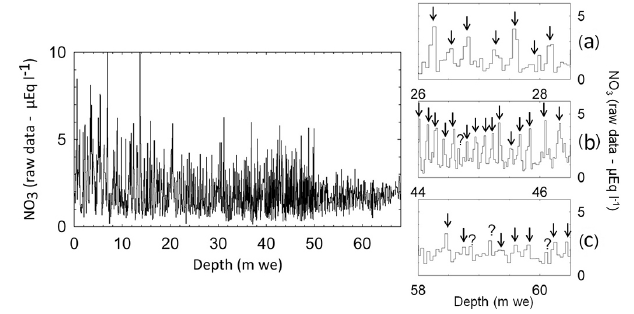
(d) showing the concentration from 0 Figure 1. Raw data of c NO − 3 to 70mwe depth. Arrows denote winter maxima. (a) Multi-proxy dating approach (de Angelis et al., 2003); (b) and (c) : visual count- ing (this